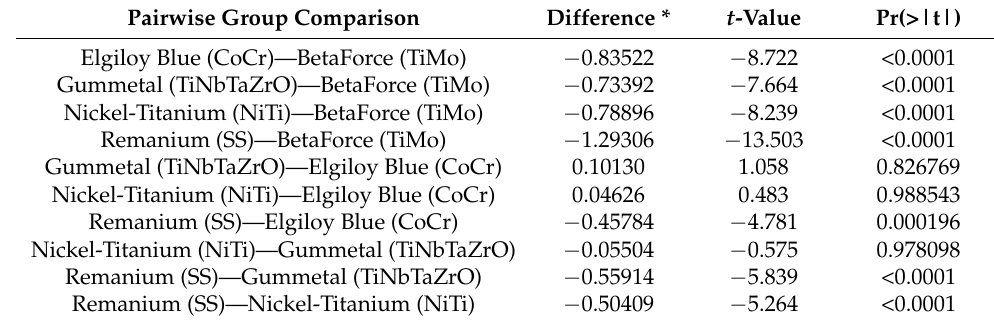
Table 5. Defining the homogeneity of variances.